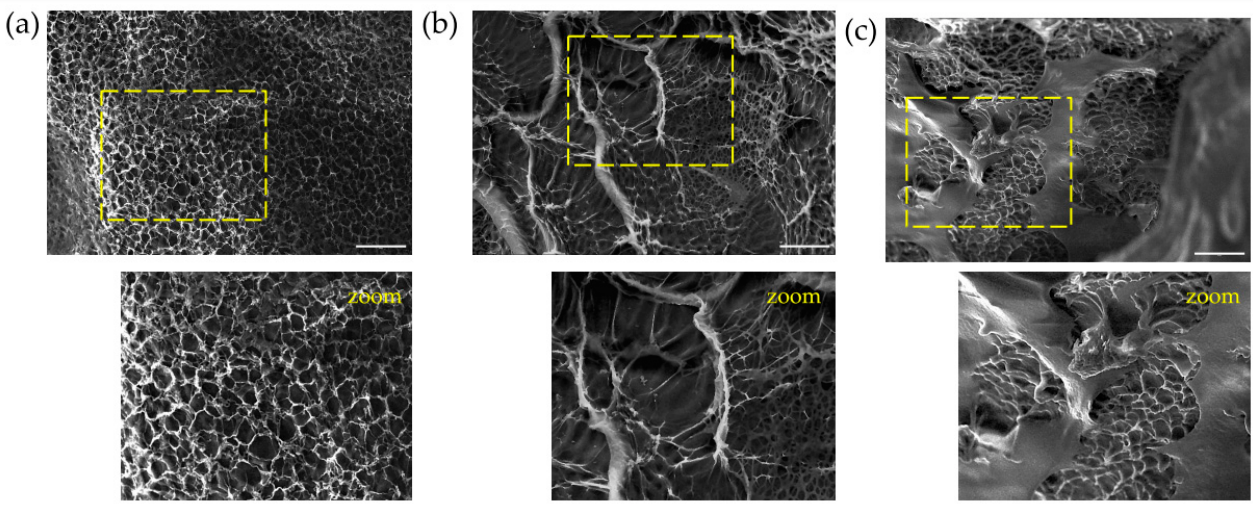
Figure 4. SEM micrographs of cross-section morphology of hydrogels after lyophilization. ( a ) net -GE, ( b ) net -GE/PVP IPN (10% NVP solution), and ( c ) net -GE/PVP IPN (15% NVP solution). Magnification: 1000×. Scale bar: 50 µm.